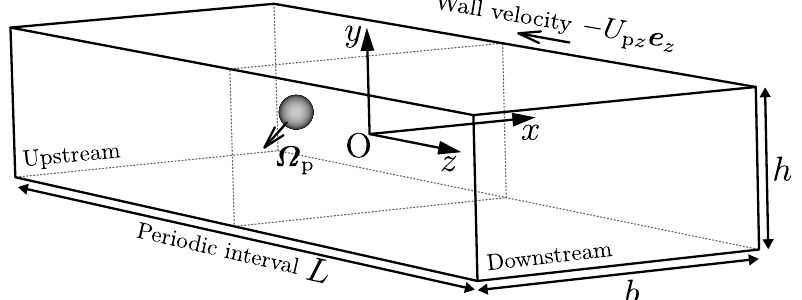
Figure 1. Flow configuration. Galilean transformation in the streamwise direction is